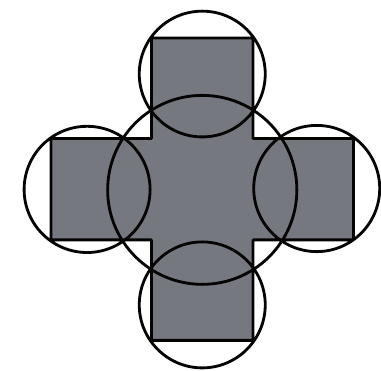
Fig. 13. Component and its